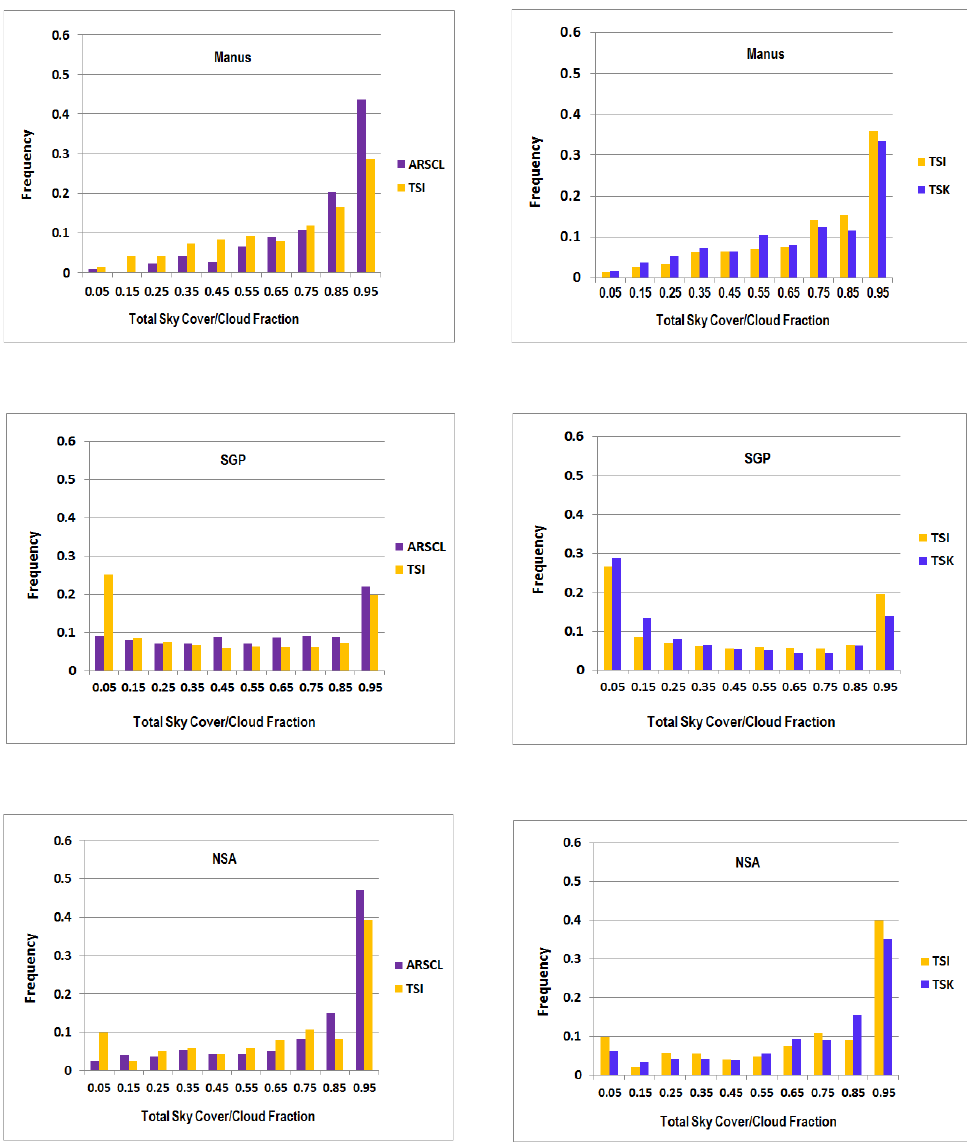
Fig. 4. The frequency distribution for daily total sky cover or cloud fraction (left: ARSCL vs. TSI; right: TSI vs. TSK) over Manus (top), SGP (middle) and NSA